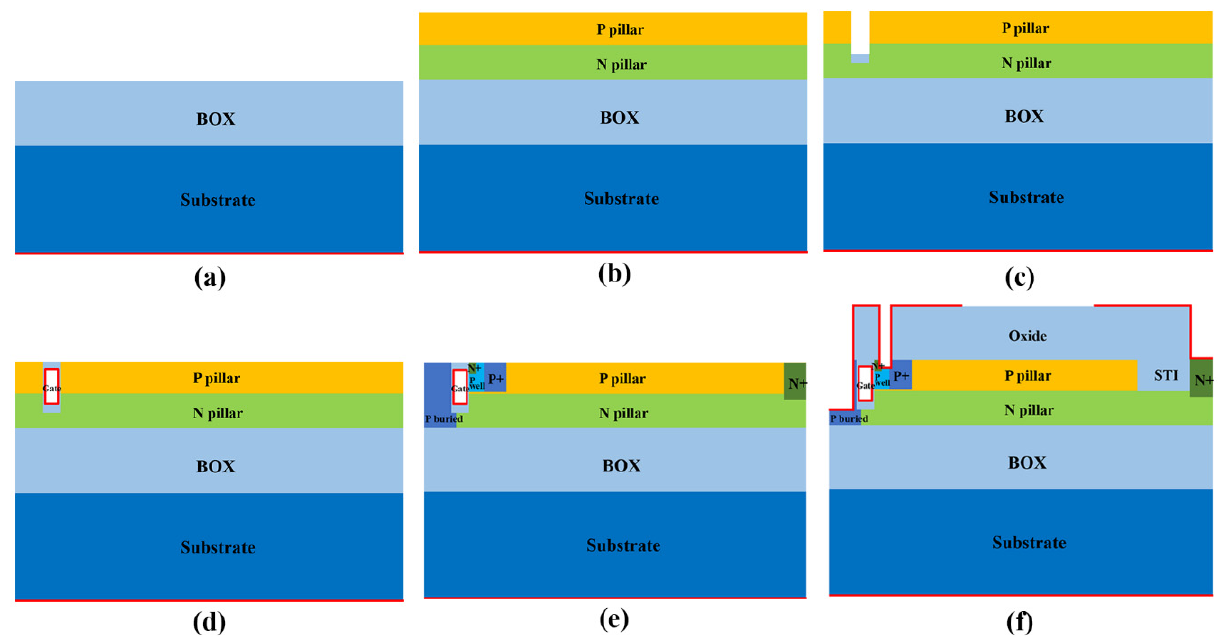
Figure 2. Fabrication process steps for the SJT SOI LDMOS, ( a ) deposit oxide on the substrate; ( b ) N pillar and P pillar are formed by depositing; ( c ) trench is formed by ion etching and the thick oxide is deposited on the bottom of the trench; ( d ) gate oxide wall is thermally grown and polysilicon is deposited; ( e ) the p+ and n+ ions are implanted; ( f ) STI region is formed by etching and depositing and the metal is deposited.